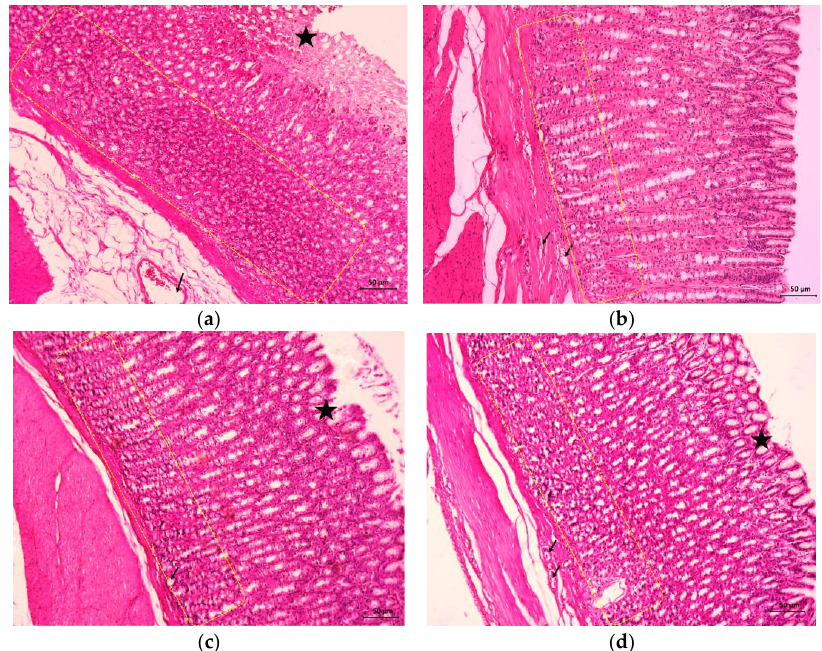
Figure 2. Histological study of ethanol-induced gastric ulcer in rats pretreated with 1 mL/kg of distilled water (control group) ( a ), 20 mg/kg of omeprazole (positive group) ( b ), 1 mL/kg of H-BSO ( c ), and 1 mL/kg of L-BSO. ( d ) Black star, disruption to the surface epithelium; black arrow, congested or dilated blood vessel; yellow dotted border, inflammatory cell infiltrations in the mucosal layer (hematoxylin and eosin, magnification 10×).